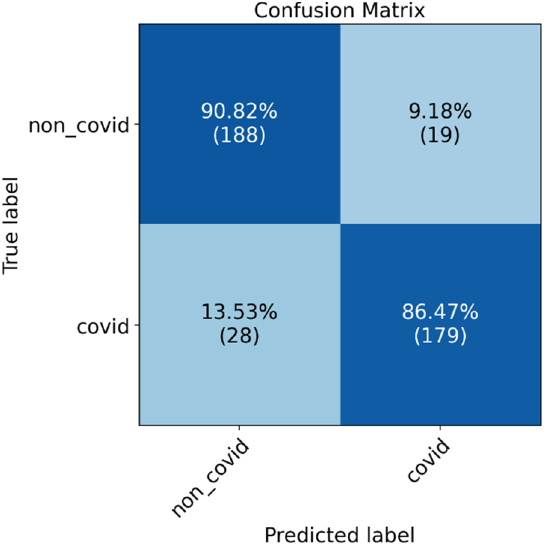
Figure 9. Precision-recall curves for model evaluation on both test datasets. ( a ) Results for test da- taset 1 and ( b ) results for test dataset 2. 1 and ( b ) results for test dataset 2.